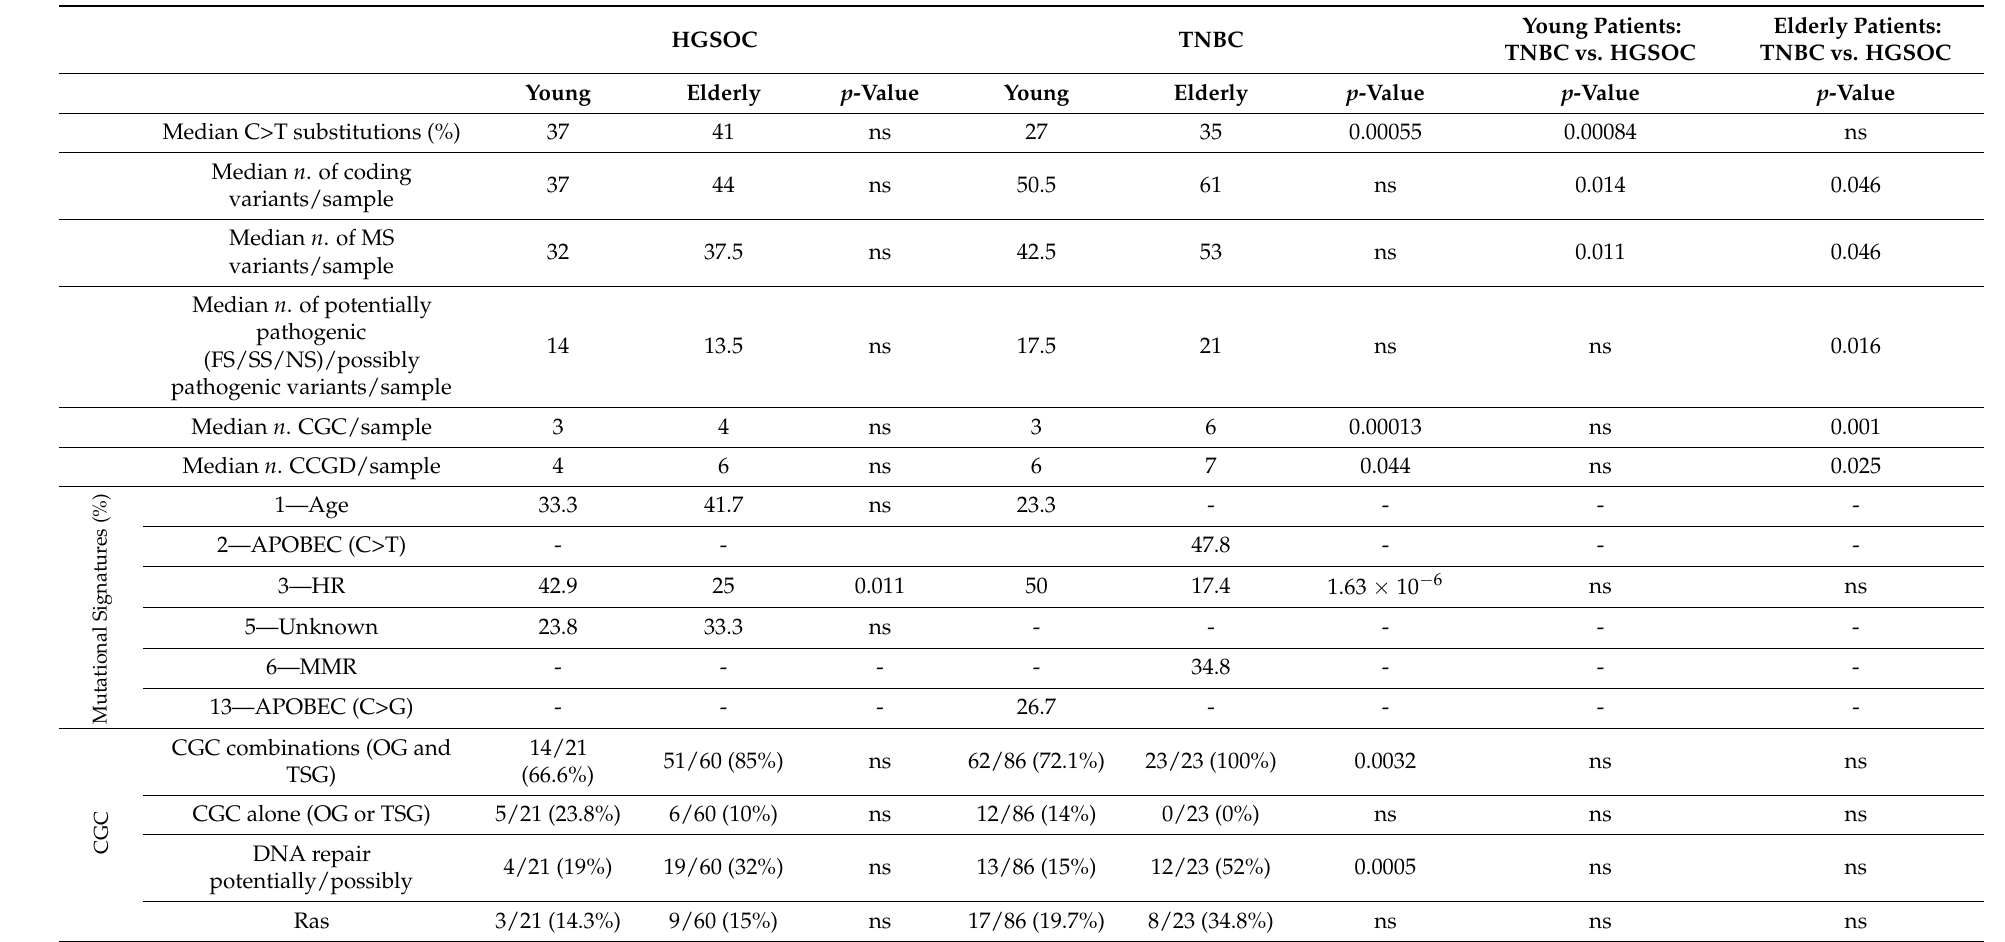
Table 1. Cancer and age groups summaries and